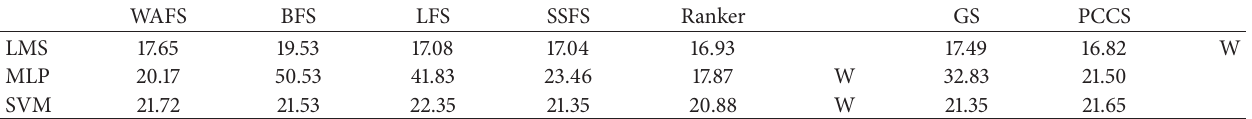
Table 4: Achieved MAPE after applying various wrapper selection methods on LMS, MLP, and SVM. WAFS BFS LFS SSFS Ranker PCCS LMS 17.65